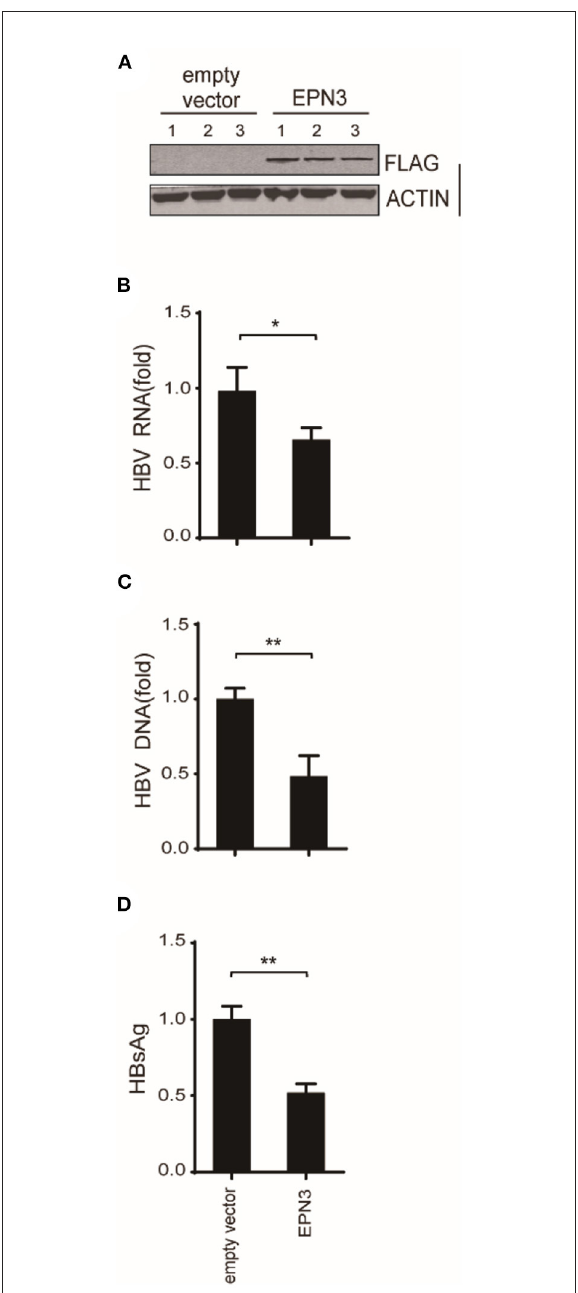
FIGURE3 EPN3-mediated HBV RNA reduction in hydrodynamic-based mouse HBV model. C57BL/6 mice were hydrodynamically administrated with pPB and the FLAG-EPN3 or the empty vector ( n = 3, each for the empty vector and EPN3). (A) Western blot analysis of the transfected liver. (B) HBV RNA levels were determined by RT-qPCR. (C) qPCR analyses of cytoplasmic HBV DNA. (D) The levels of HBsAg were measured in serum by ELISA. The level of the empty vector sample is defined as value 1. * P < 0.05, ** P <